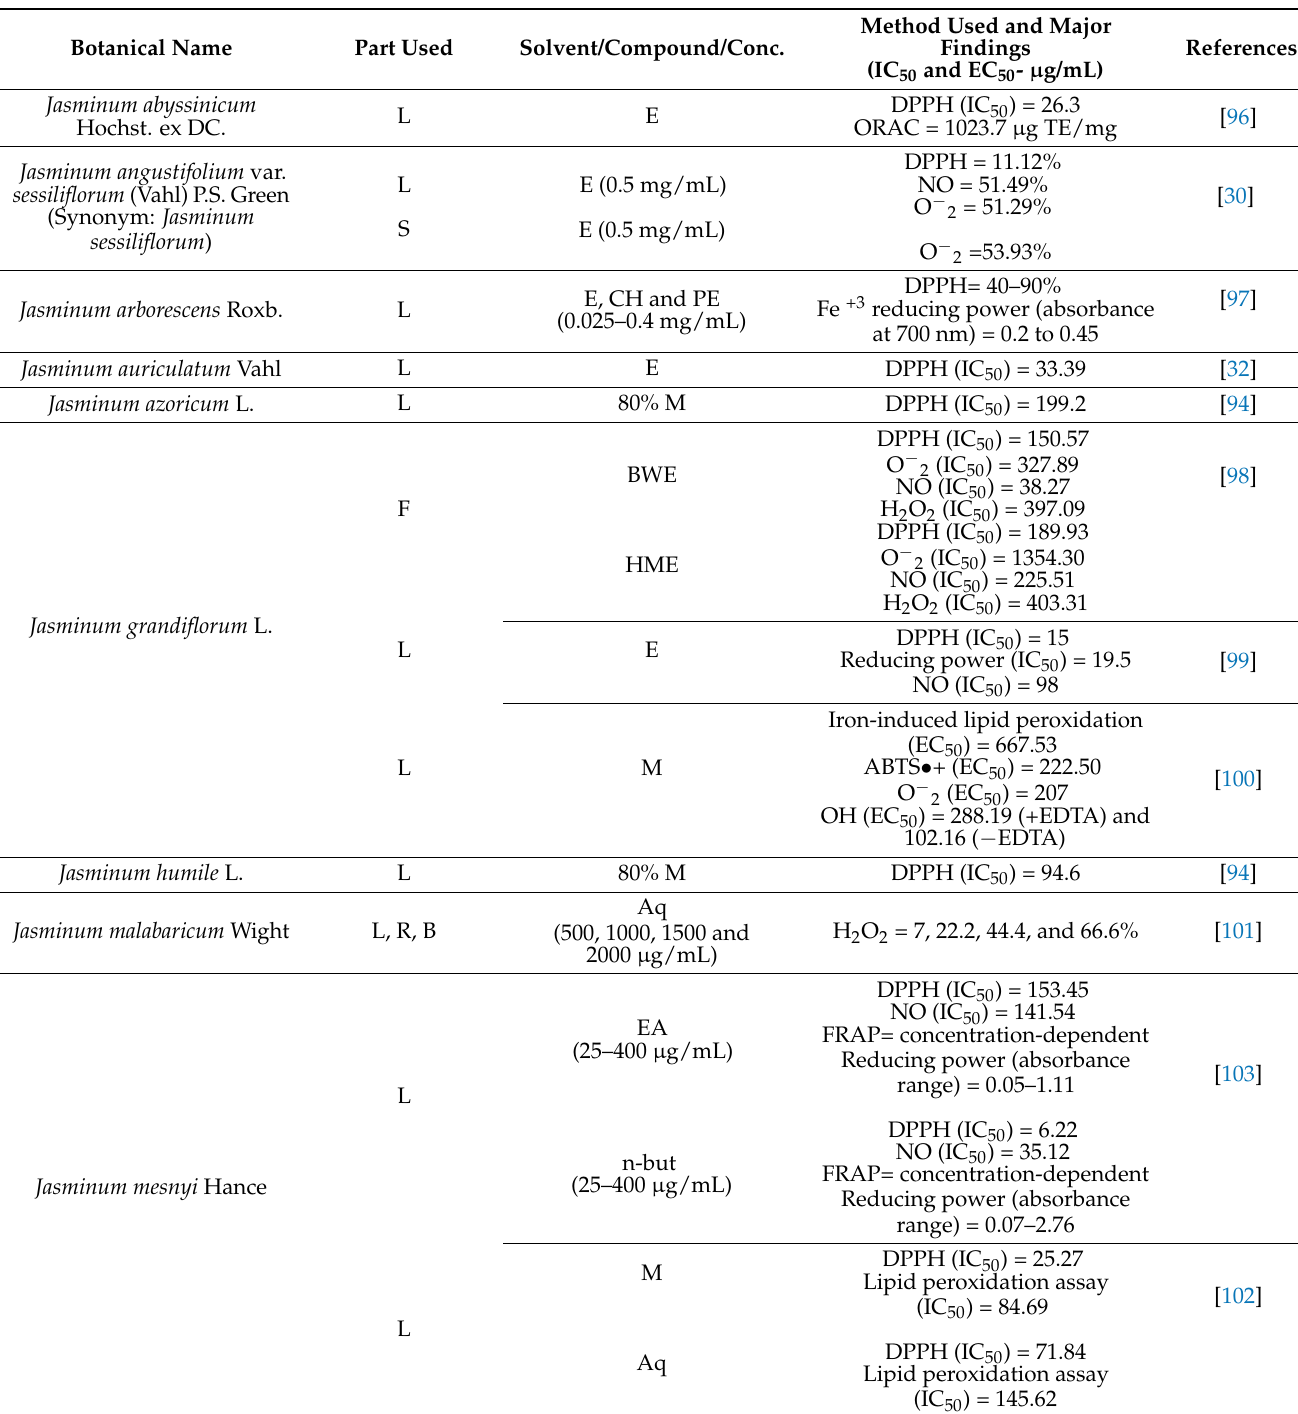
Table 2. In vitro antioxidant activity of Jasminum